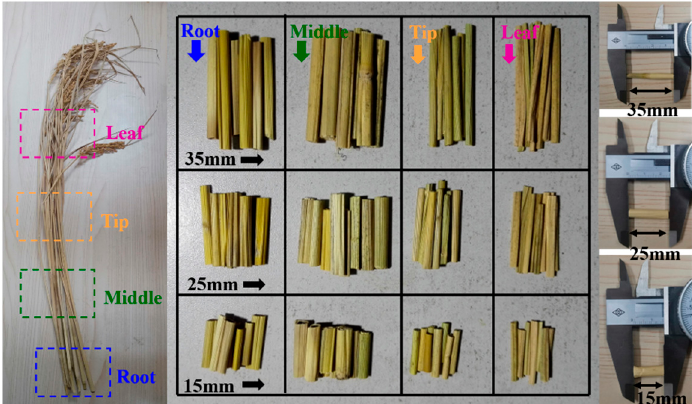
Figure 2. Suspension speed test material.